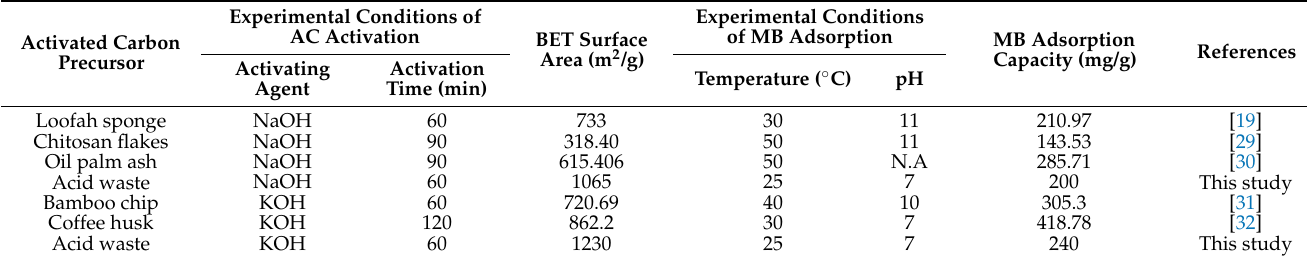
Table 1. Comparison of adsorption capacity of MB of various activated carbon